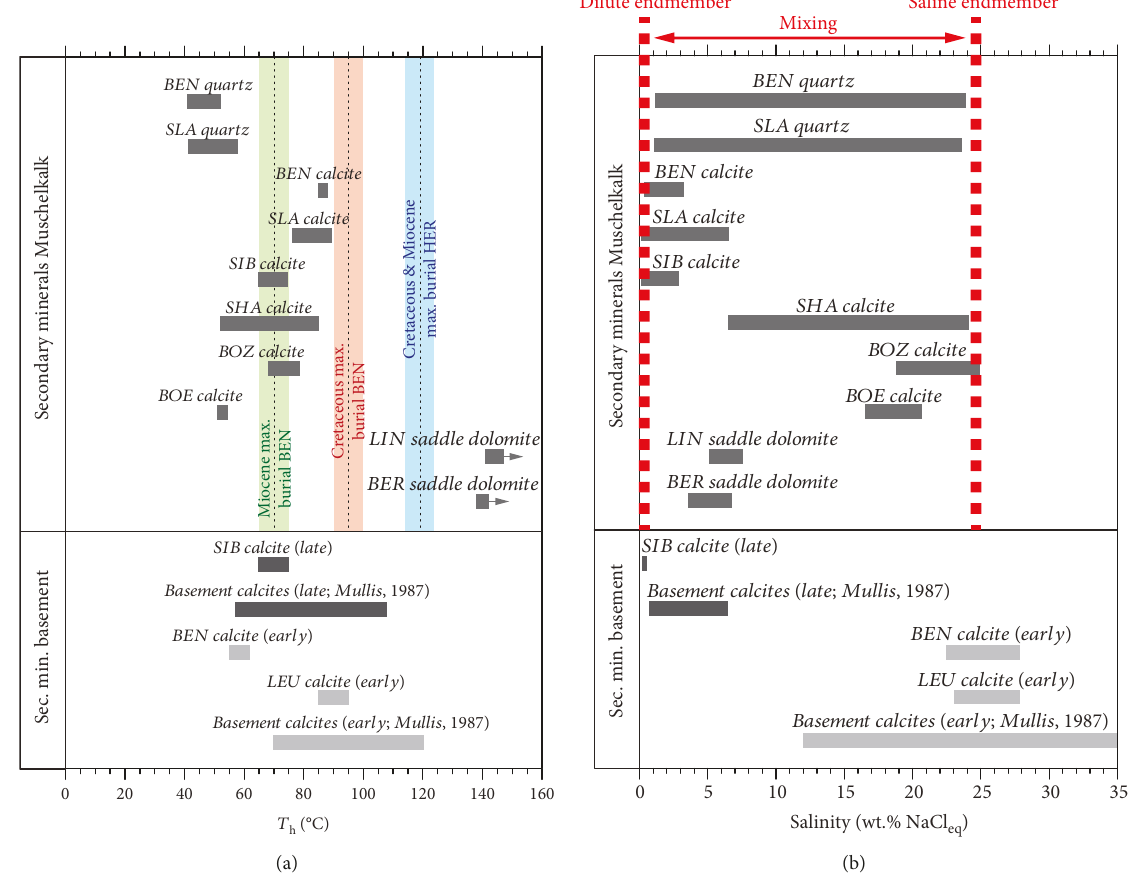
Figure 10: Microthermometric results from primary fl uid inclusions in secondary minerals from the Muschelkalk and the crystalline basement at various wells across the Swiss Molasse Basin. (a) Homogenization temperatures ( T h ). For the data from Mullis [43] and for saddle dolomites, the T h values correspond to minimum temperatures of fl uid trapping. For all other data, T h corresponds to the exact trapping temperature (see text for explanation). Maximum rock temperatures during Cretaceous and Miocene maximum burial (Figure 2) are plotted for comparison. (b) Salinities calculated from ice-melting